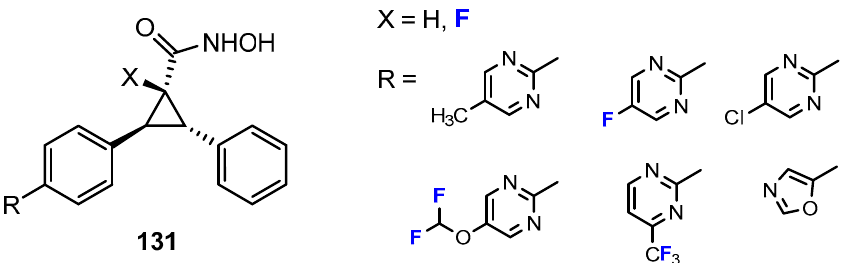
Figure 4. Chemical structures of fluorinated hydroxamic acids by Luckhurst [69].